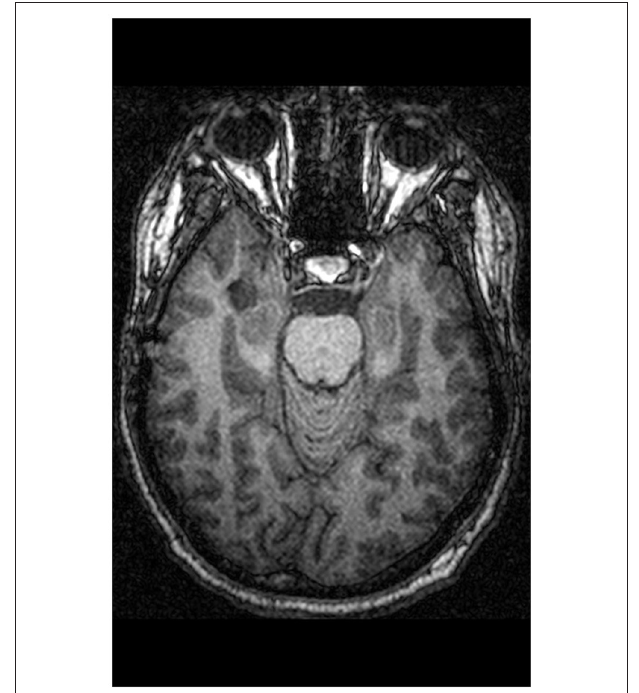
FIGURE 1 | Lesion dimensions, location: temporo-basal